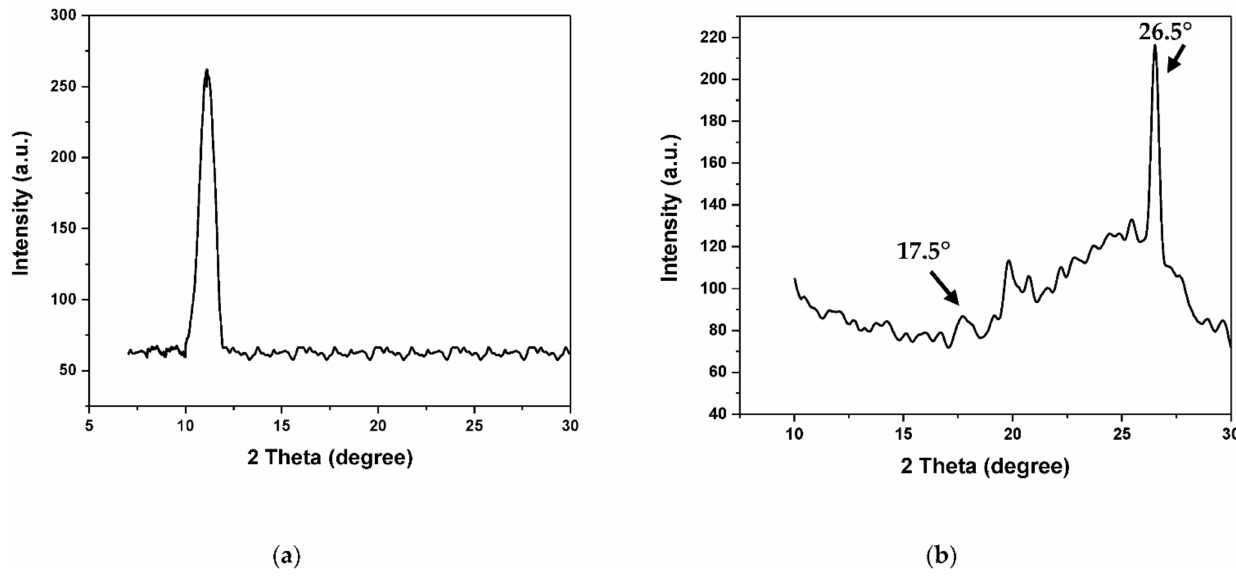
Figure 5. XRD analysis of graphene oxide ( a ) [2] and aminated graphene oxide ( b